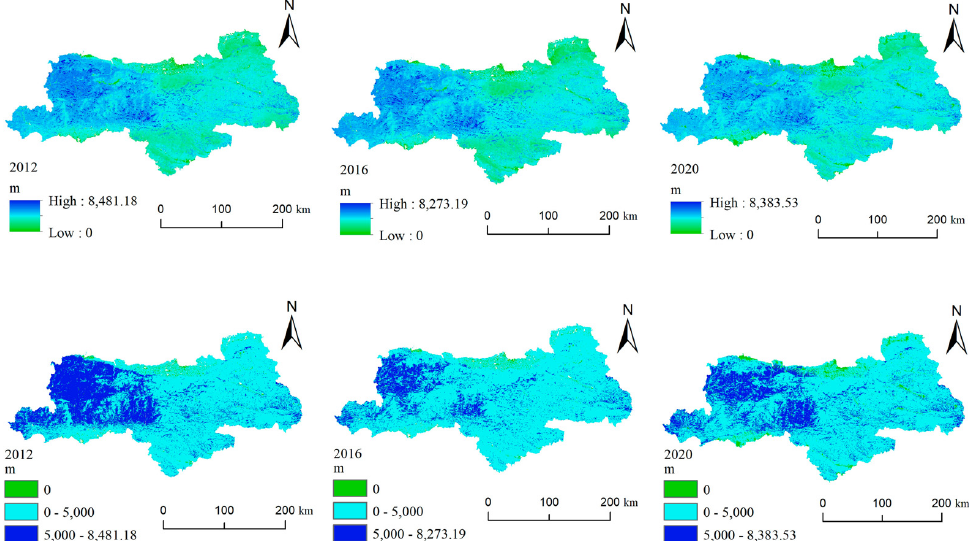
Figure 5. Spatial and temporal distribution of carbon neutralization service range at pixel scale in Qinling Mountains.